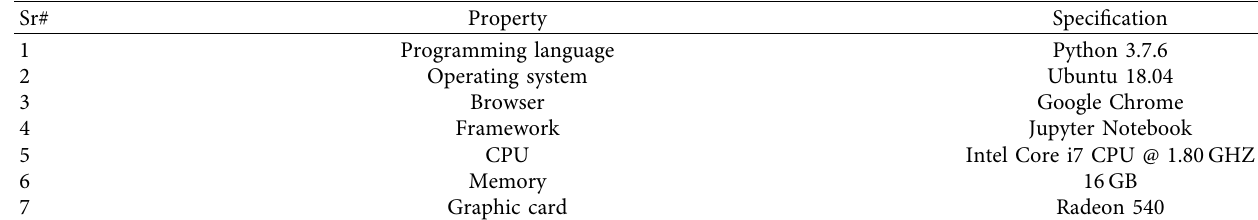
Table 2: Simulation